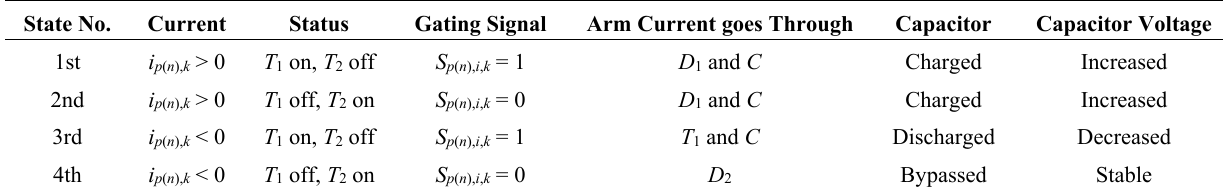
Table 3. Failure Mechanism of Open-Circuit Fault in T 2